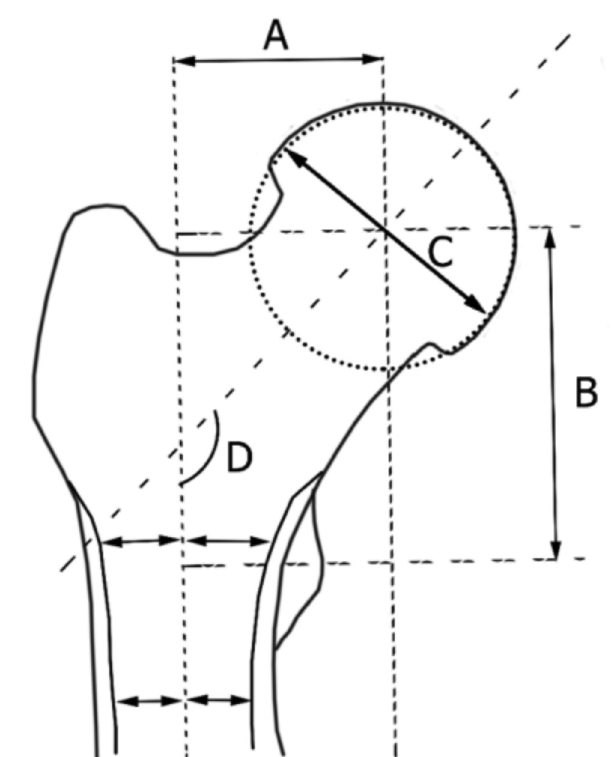
Illustration of proximal femur with morphological measurements. (A) medial femoral offset, (B) vertical femoral offset, (C) Fig. 1: femoral head diameter, (D) neck shaft